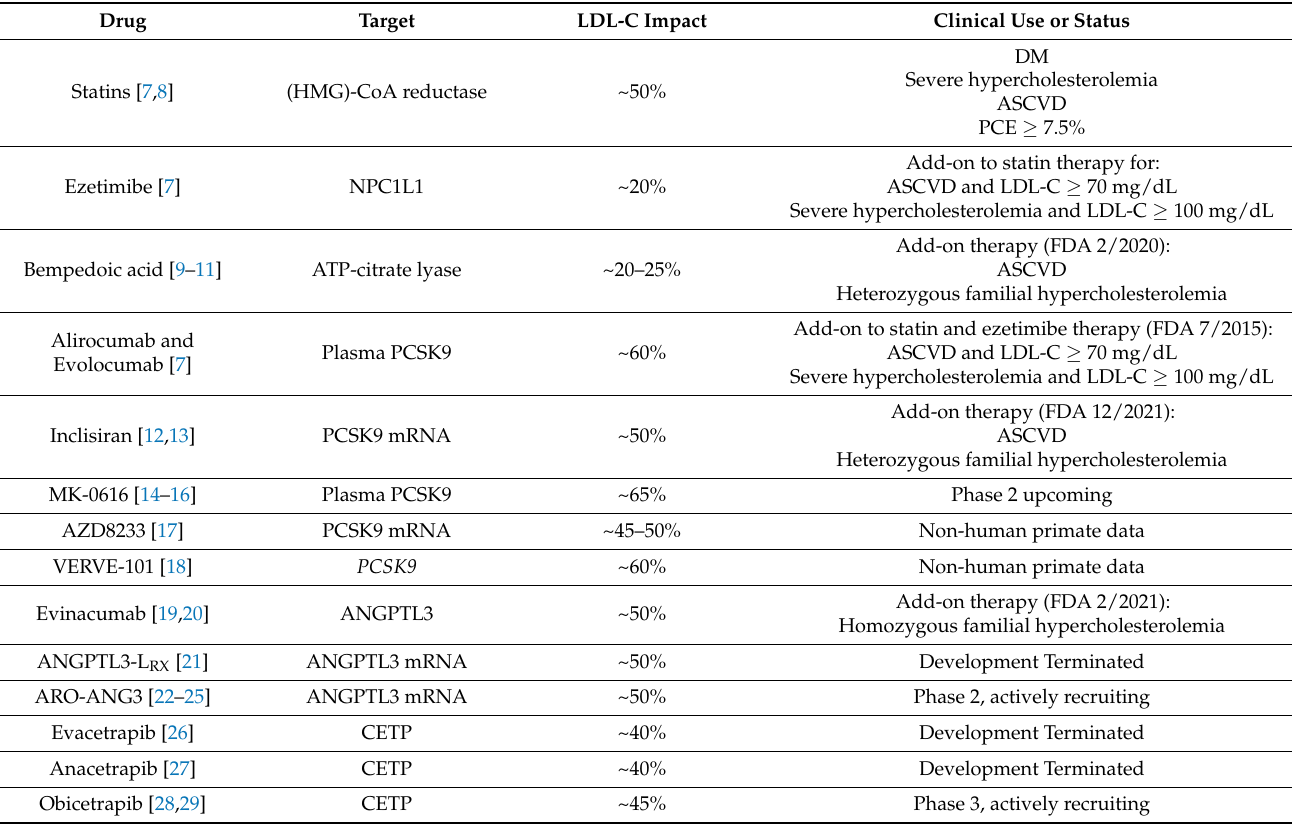
Table 1. Current, new, and emerging LDL-C lowering